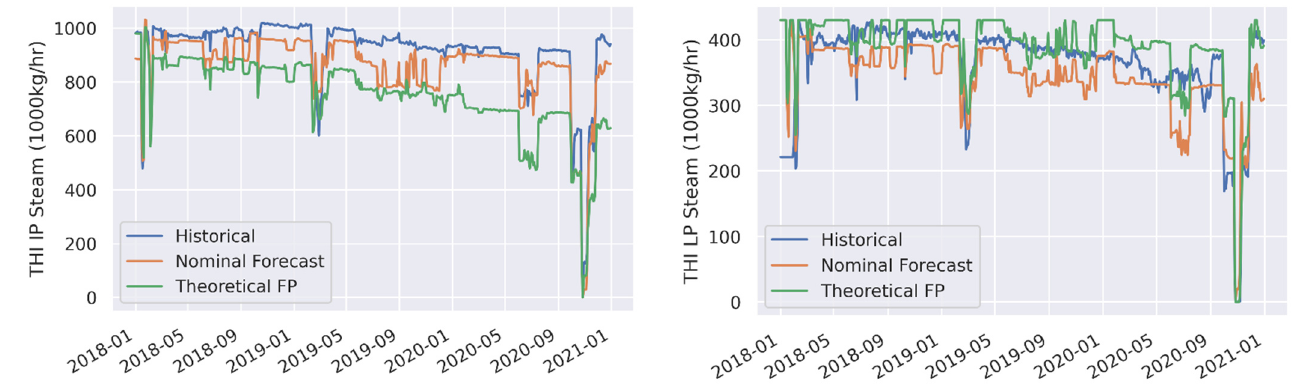
Figure 5. Intermediate pressure ( left ) and low pressure ( right ) separated steam flow to the Te Mihi power station, com- paring historically measured data versus the nominal forecast model (including the neural network flash plant model) and the theoretical flash plant forecast (using steam quality at separation pressure as separation efficiency).